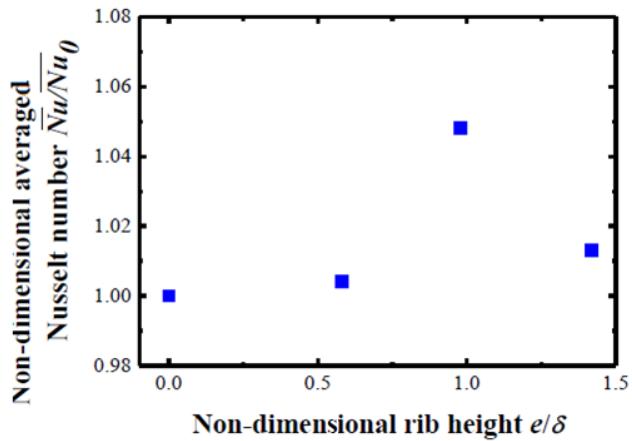
Figure 6. Effect of circular rib height on the averaged Nu (at the fixed circular rib location of r / D = 3.5). Table 3. Experimental conditions of circular ribs.